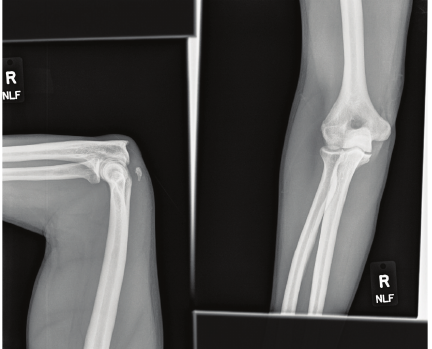
Figure 6: Plain radiograph, right elbow with avulsion